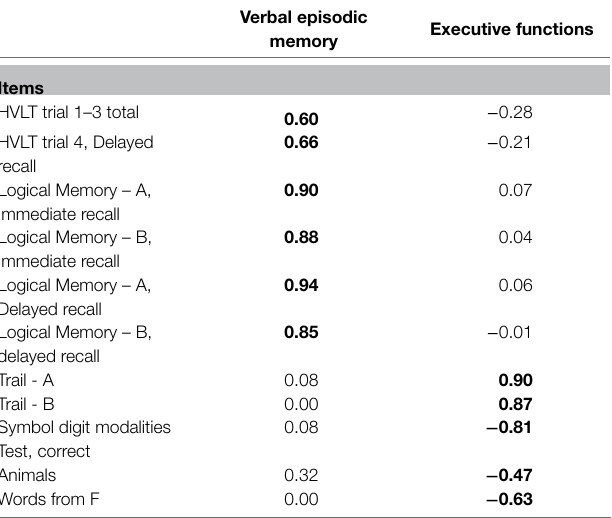
TABLE 1 | Factor loadings for each test to VEM and EF components.